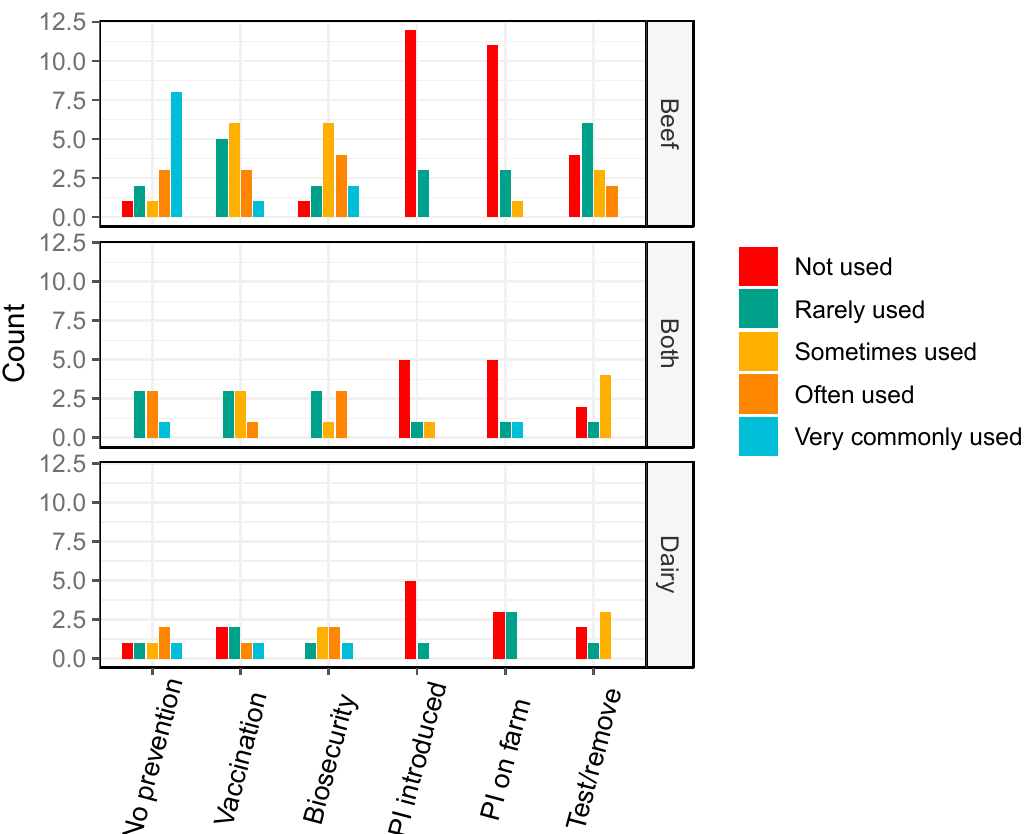
Figure 5. Barplots of the frequency of management practices used on bovine viral diarrhoea virus (BVDV) negative properties reported by veterinarians, in a survey of veterinarians’ knowledge, attitudes and practices associated with BVDV management on farms in the temperate zone of south-east Australia in 2019. PI = persistently infected cattle.